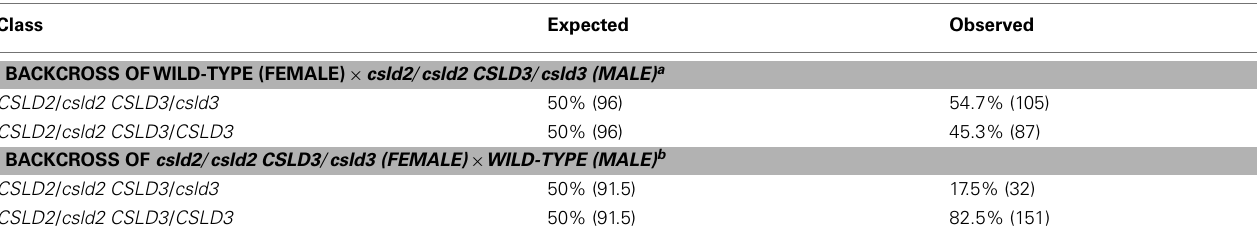
Table 2 | Genetic analysis of csld2 / csld2 CSLD3 / csld3 indicates defects in female transmission. Class